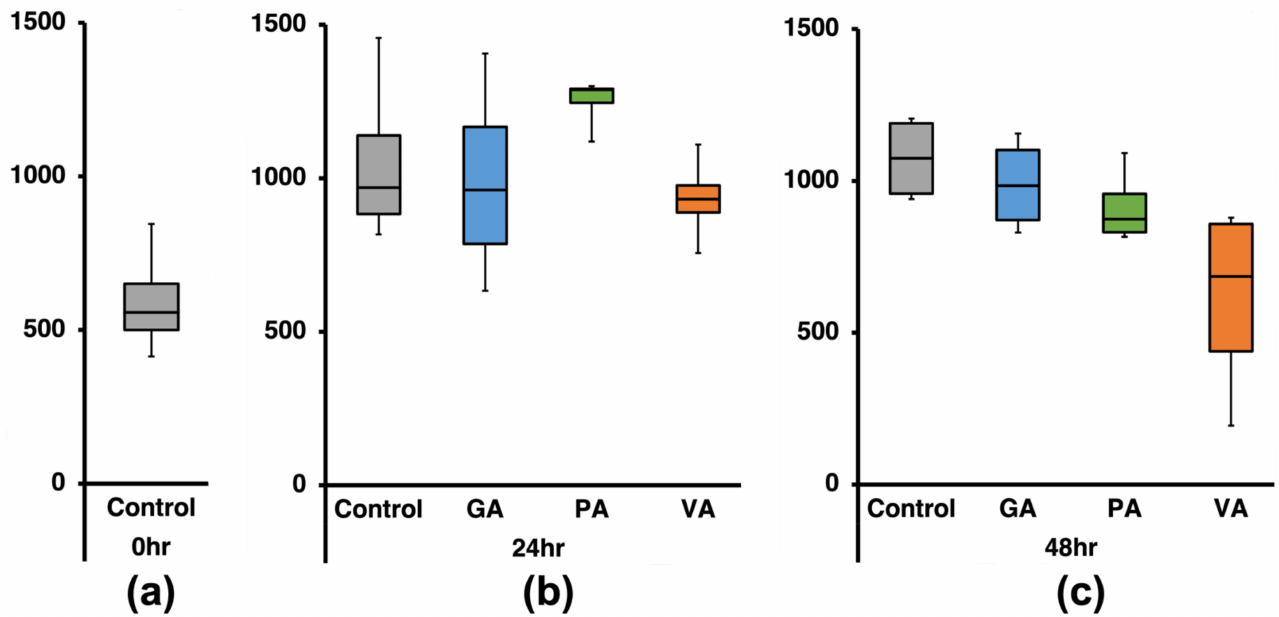
Figure 4. Number of identified species in 16S-rRNA gene sequencing data at 0 h ( a ), 24 h ( b ), and 48 h ( c ) for an untreated control and groups individually treated with either gallic acid (GA), protocatechuic acid (PA) and vanillic acid